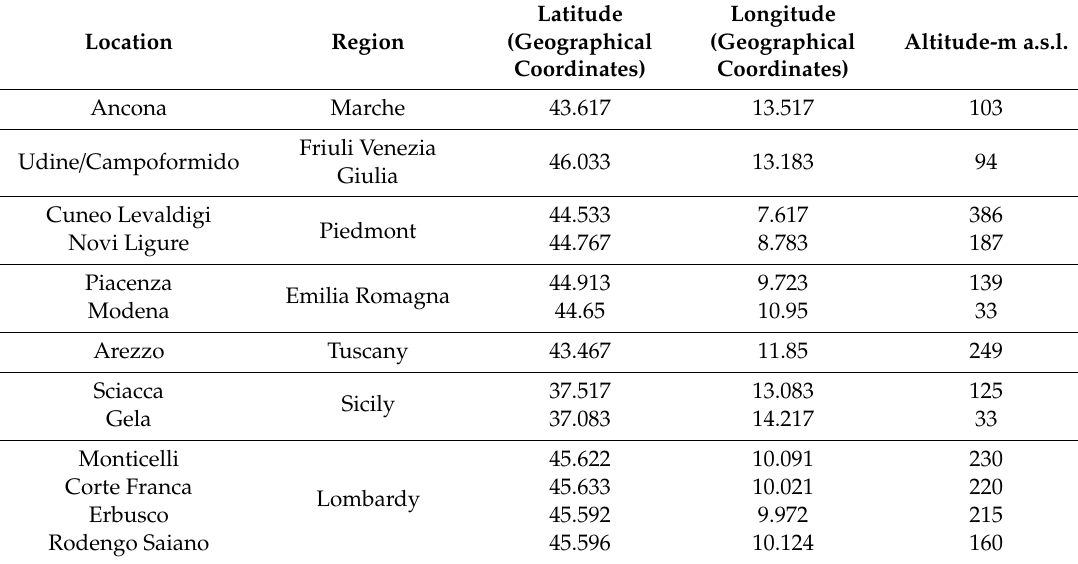
Table 1. Location of meteorological